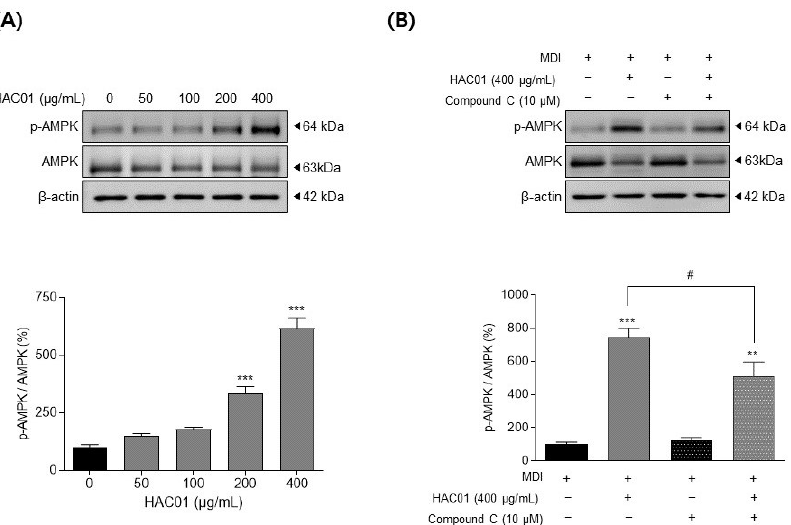
Figure 7. Effects of Lactobacillus plantarum HAC01 lysate on AMPK activation in 3T3-L1 cells. Adipocyte differentiation was induced in the presence of L. plantarum HAC01 lysate for 2 d. ( A ) Protein expression levels of p -AMPK/AMPK quantified using Western blotting. ( B ) Protein expression levels of p -AMPK/AMPK, with or without Compound C, quantified using Western blotting. Representative bands from triplicate experiments are shown. AMPK, adenosine monophosphate-activated protein kinase. All results are presented as mean ± SD. ** p < 0.005 and *** p < 0.001 vs. 0 μg/mL; # p < 0.005 vs. 400 μg/mL.